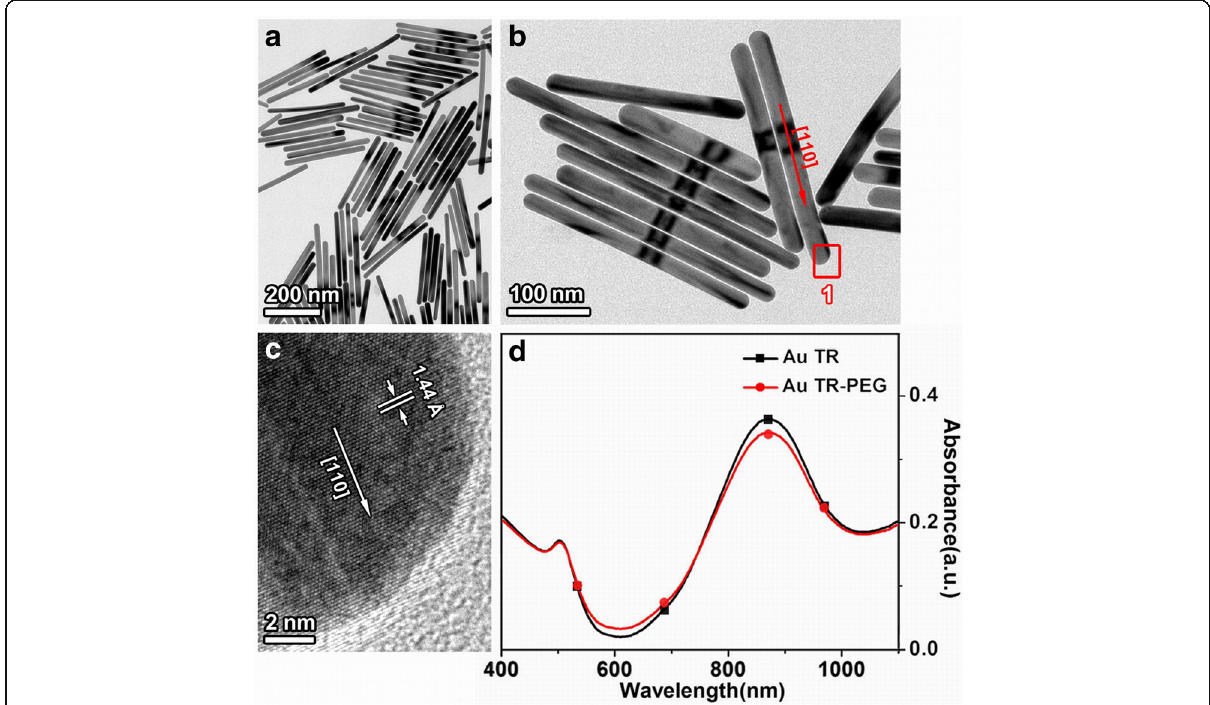
Fig. 1 Typical morphology and structure of Au nanorod synthesized at 25 μ L 0.1 M AA (AuTR): a Bright-field TEM image. b Amplification TEM image, of a single rod. c HRTEM image of a single rod in rectangular area “ 1 ” from panel b . d UV-vis absorption spectra of AuTR and